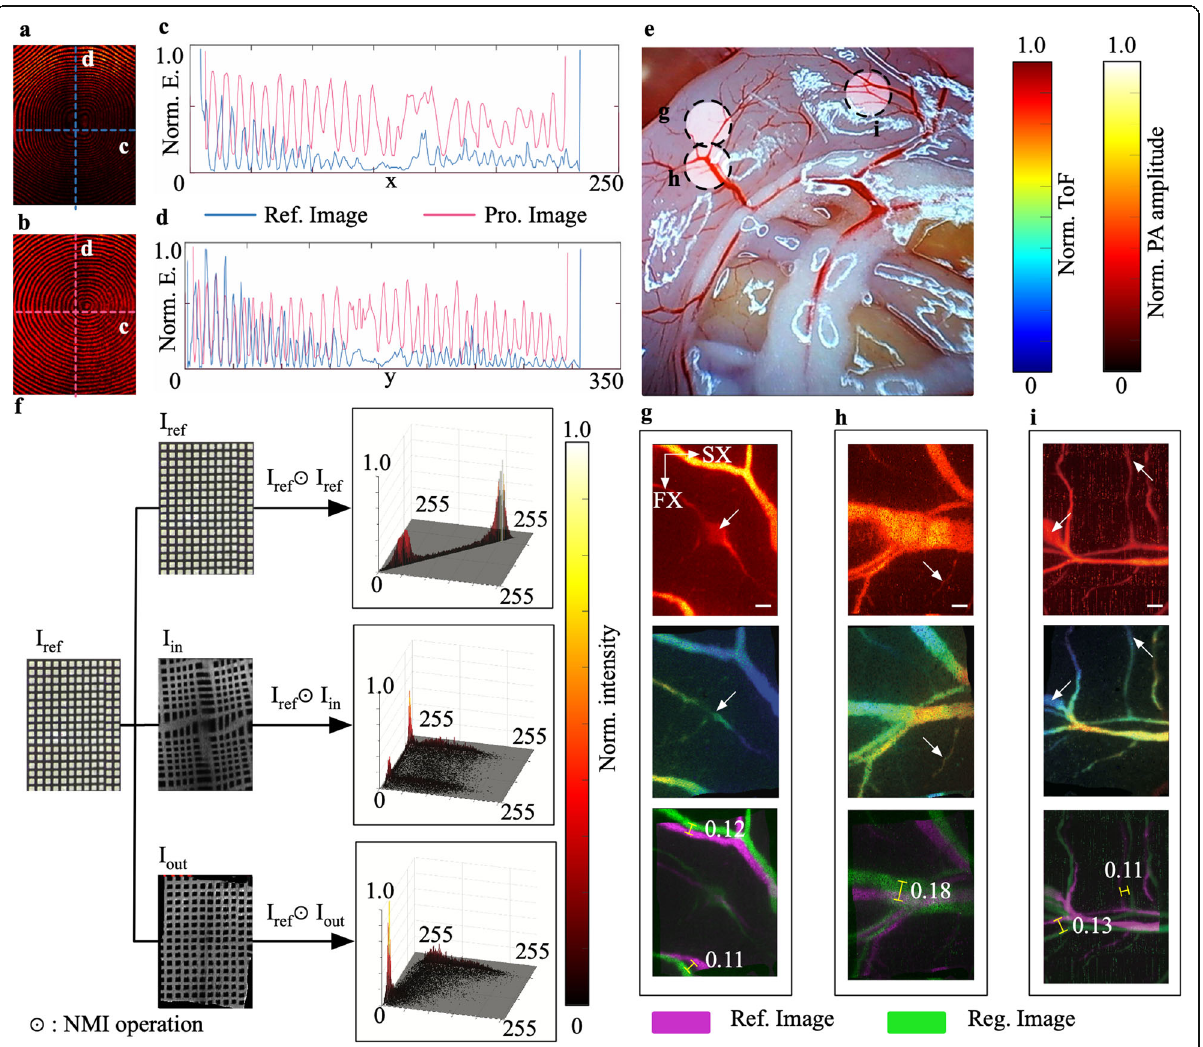
Fig. 5 Experimental results of image reconstruction with SWM. a : Original MAP image of a ring texture resolution chart; b : The processed MAP image of Fig. a ; c : Horizontal profile along colored dashed-lines in a and b rendered with different colors; d : Vertical profile along colored dashed-lines in Figs. a and b; e : Image of vessels in the abdomen of a laboratory rat; f : Joint histogram comparison of different images; g - i : The above images of g-i are distorted images; the middle images are the corrected depth-coded images (processed images); the lower images of g - i are superimposed images between the original images and the processed images; white-arrows and rulers are utilized to mark obvious correction. Norm.: Normalized; ToF: Time of flight; Pro.: Processed; Ref.: Reference; Reg.: Registered; units: μ